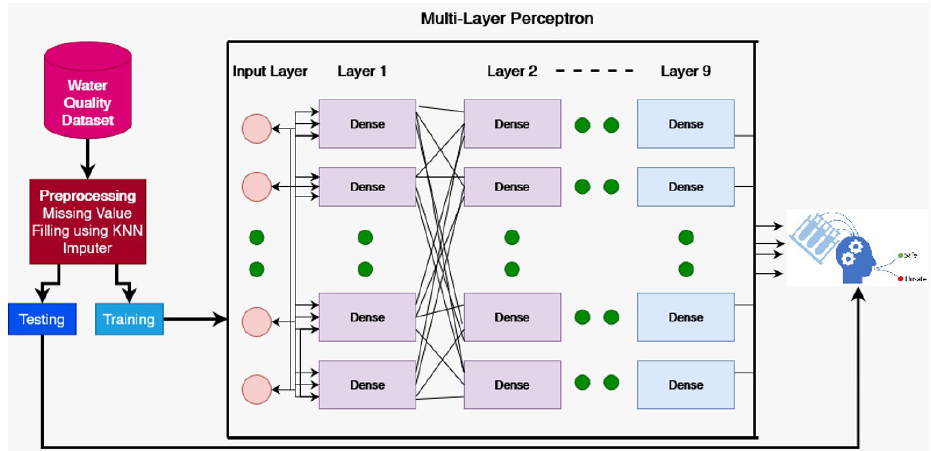
Figure 1. Architecture of the proposed approach.